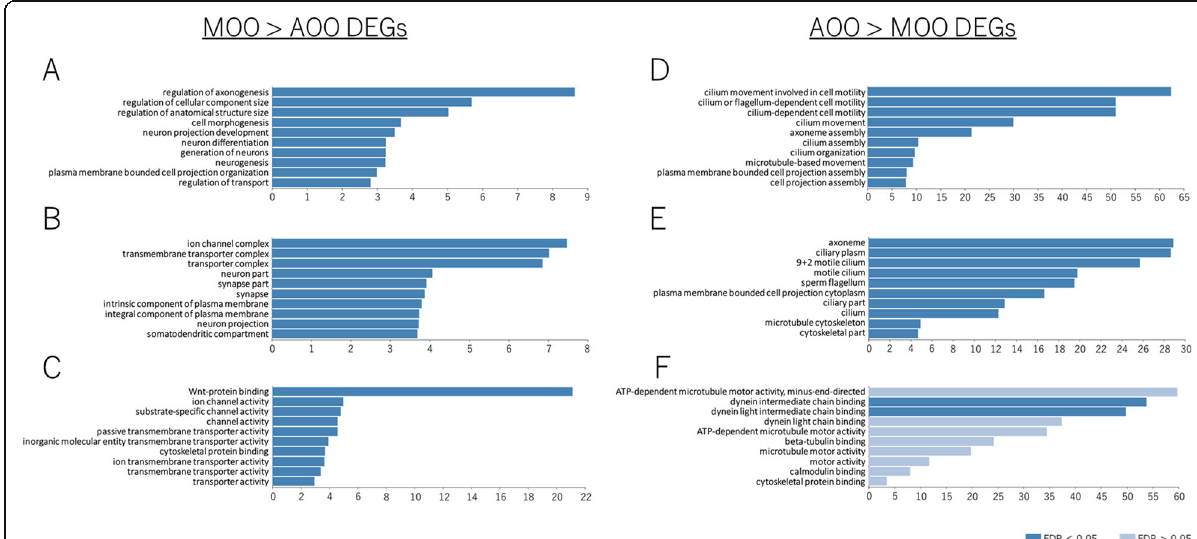
Fig. 3 Gene ontology (GO) analyses of significant DEGs between the MOO and AOO of bichir. ( A - C ) and ( D - F ) indicate the GO terms of DEGs highly expressed in MOO and AOO, respectively. These results were obtained using WebGestalt. The vertical axis shows the gene categories, and the horizontal axis shows the enrichment rate (dark blue bar: FDR ≦ 0.05, light blue bar: FDR >